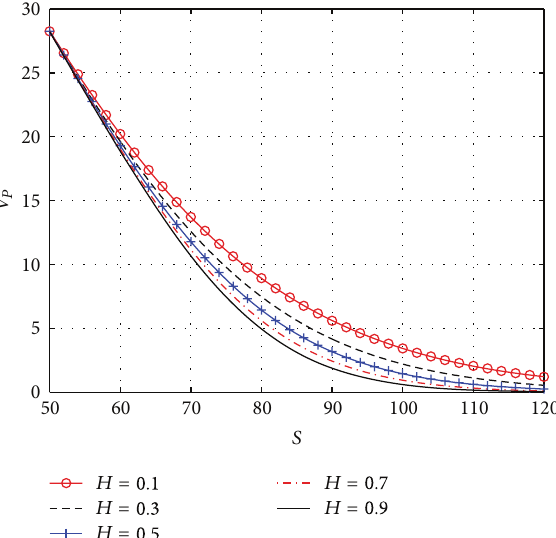
Figure 2: The values of the put option with different 𝐻 .